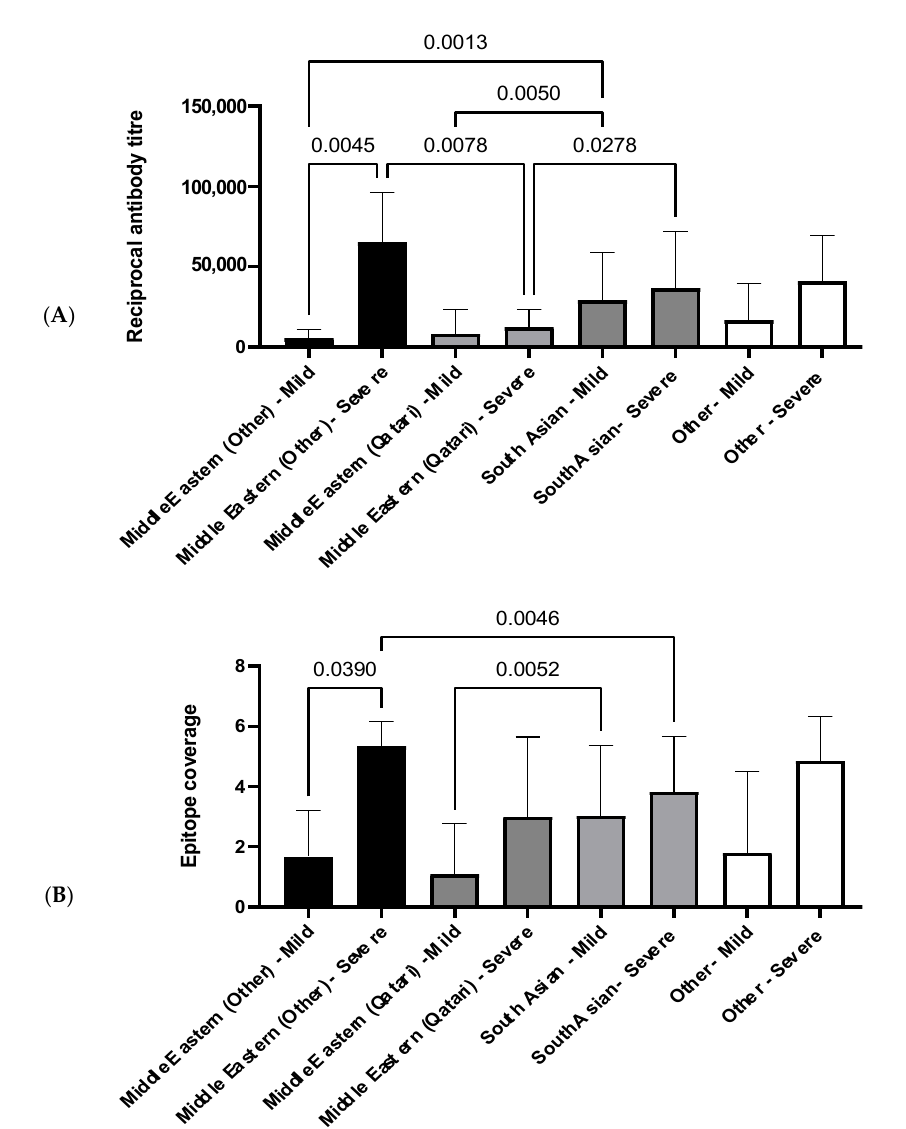
Figure 5. Histogram displaying relationship between antibody reciprocal titer and epitope coverage in Cohort 3. ( A ) Average antibody reciprocal titer for different ethnic groups and disease severities. ( B ) Average epitope coverage for different ethnic groups and disease severities. Pairwise comparisons were made using a one-way ANOVA, and p -values were calculated using Welch’s correction to compare the mean of each category with each other category. Sample sizes: Middle Eastern (other) mild: n = 2, severe: n = 6. Middle Eastern (Qatari) mild: n = 12, severe: n = 3. South Asian mild: n = 30, severe: n = 34. Other mild: n = 5, severe: n = 7.